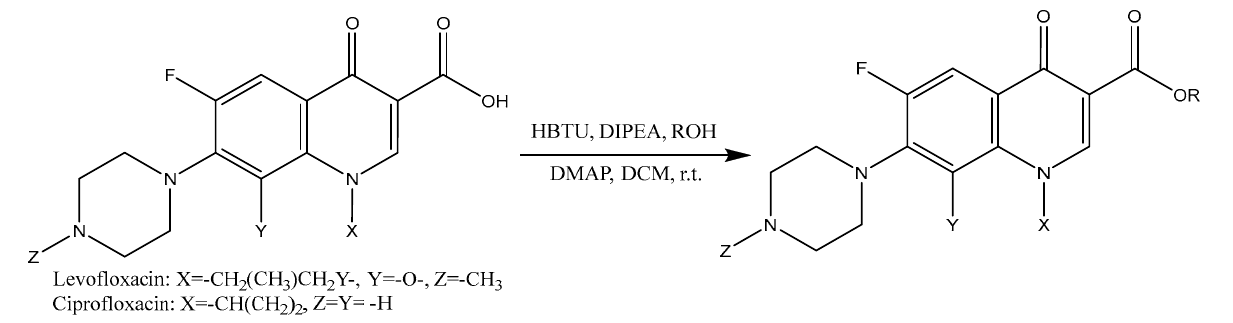
Figure 1. General synthetic scheme for fluoroquinolone esters. Table 1. Results obtained from the ester degradation percentage values, after 14 days in phosphate buffer (PBS) and after 3 days in human plasma; comparison with lipophilicity (log P). Compound R Degradation PBS